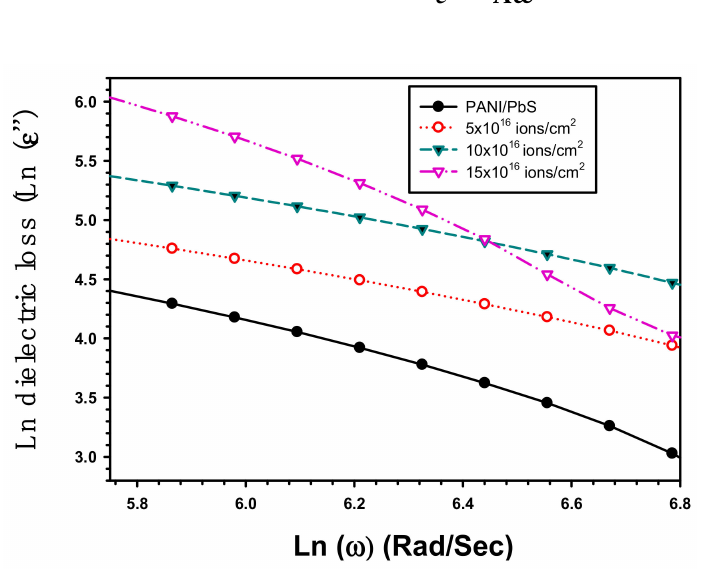
Figure 14. Ln ( ε ” ) against Ln ( ω ) for pristine and treated PANI/PbS